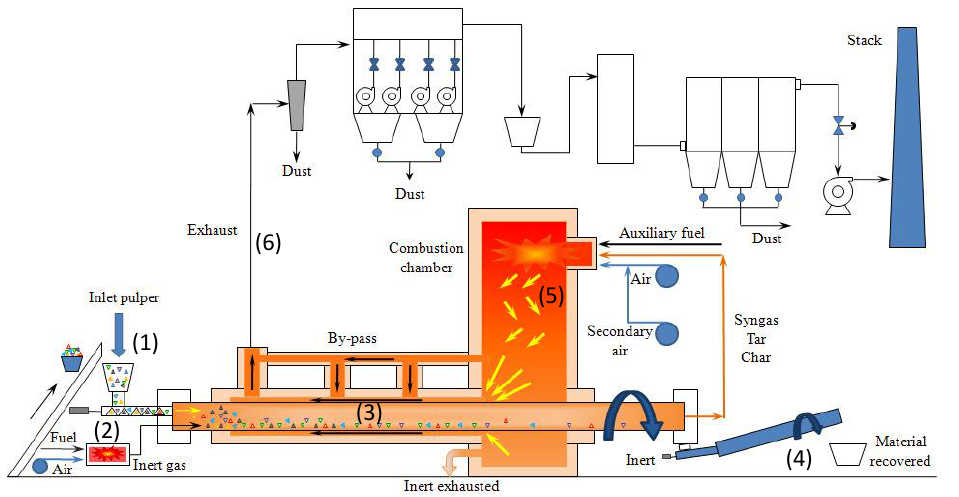
Figure 3. Scheme of the MR pyro-gasification plant. Table 1. Proximate and ultimate analysis of the adopted paper pulper.